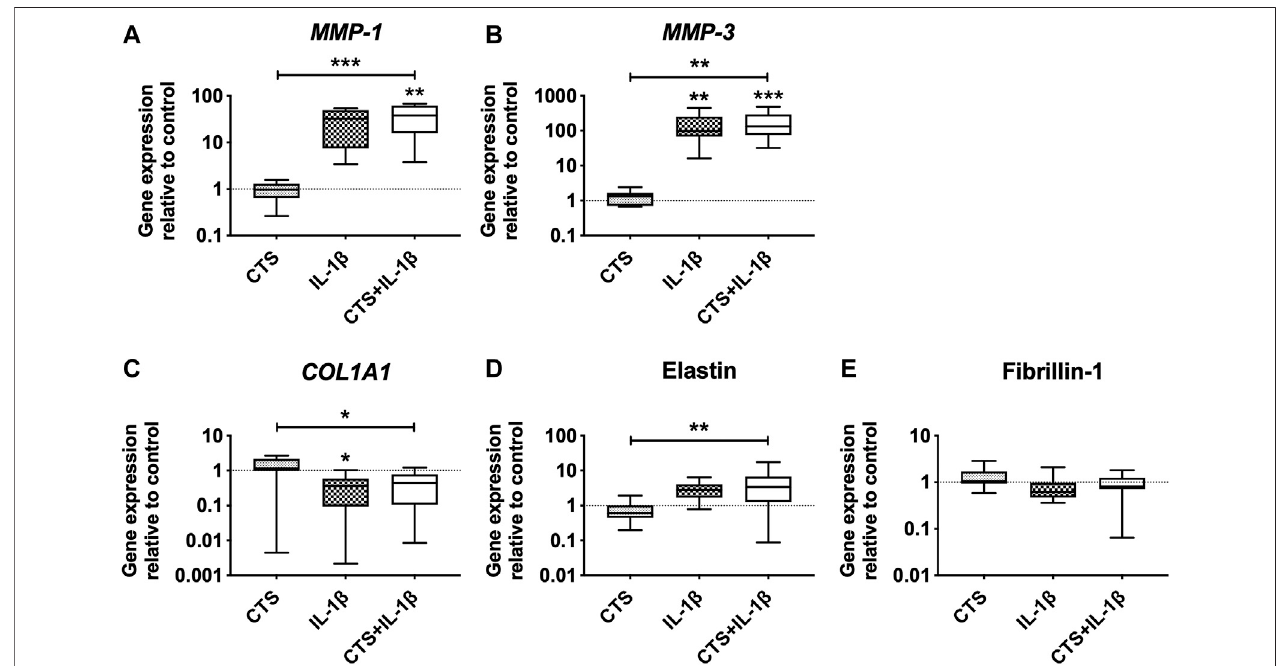
FIGURE 3 | Matrix metalloproteinases (MMPs) and extracellular matrix (ECM) gene expression of human AF cells in response to cyclic tensile strain (CTS) and to pro-in fl ammatorycytokineIL-1 β (10 ng/ml)after48 h.RelativemRNAexpressionofmatrix-degradingenzymes (A) MMP-1 , (B) MMP-3 ,andECMproteins (C) COL1A1 , (D) elastin, and (E) fi brillin-1. Results were normalized to expression level of GAPDH and unstimulated cells. n (cid:1) 10, * p < 0.05, ** p <